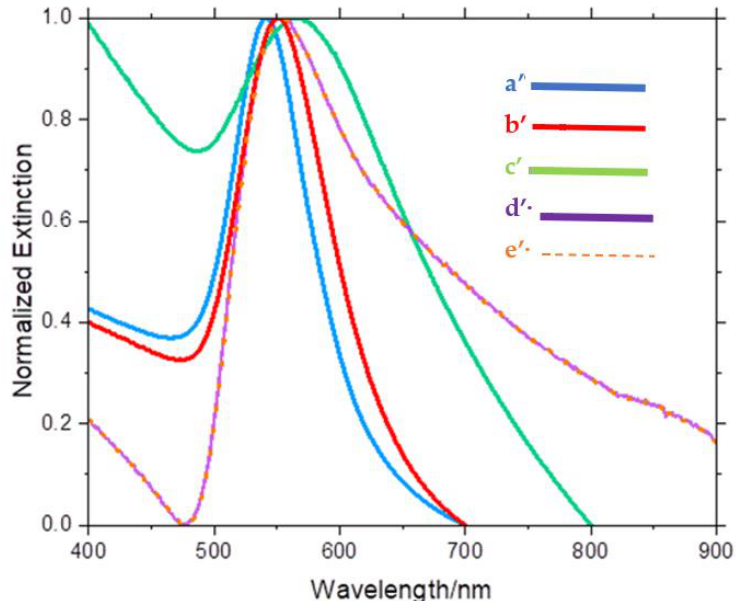
Figure 5. Experimental spectra: extinction spectra of the aqueous colloidal dispersions: AuNP@CTAB ( a’ , blue line); AuNP@SiO 2 ( b’ , red line); AuNP@SiO 2 @seed ( c’ , green line); AuNP@SiO 2 @Au ( d’ , violet line) overlapping with AuNP@SiO 2 @Au@SiO 2 ( e’ , orange dotted line).